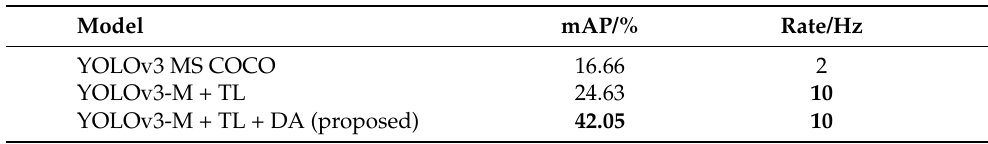
Table 2. Performance of camera detection module trained with different parameters: mAP and frame rate of detectors on SGAB dataset. Details are discussed in Section 6.2.